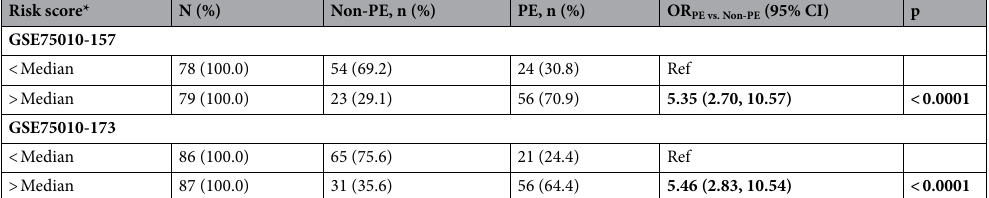
Table 2. Combined effect of the DE clock genes CRY1, NR1D2 and PER3 in placenta on the risk of overall PE with firth logistic regression model for two independent datasets. *Risk score = CRY1 + (11- NR1D2 ) + (9- PER3 ). Bold values denote statistical significance (p <